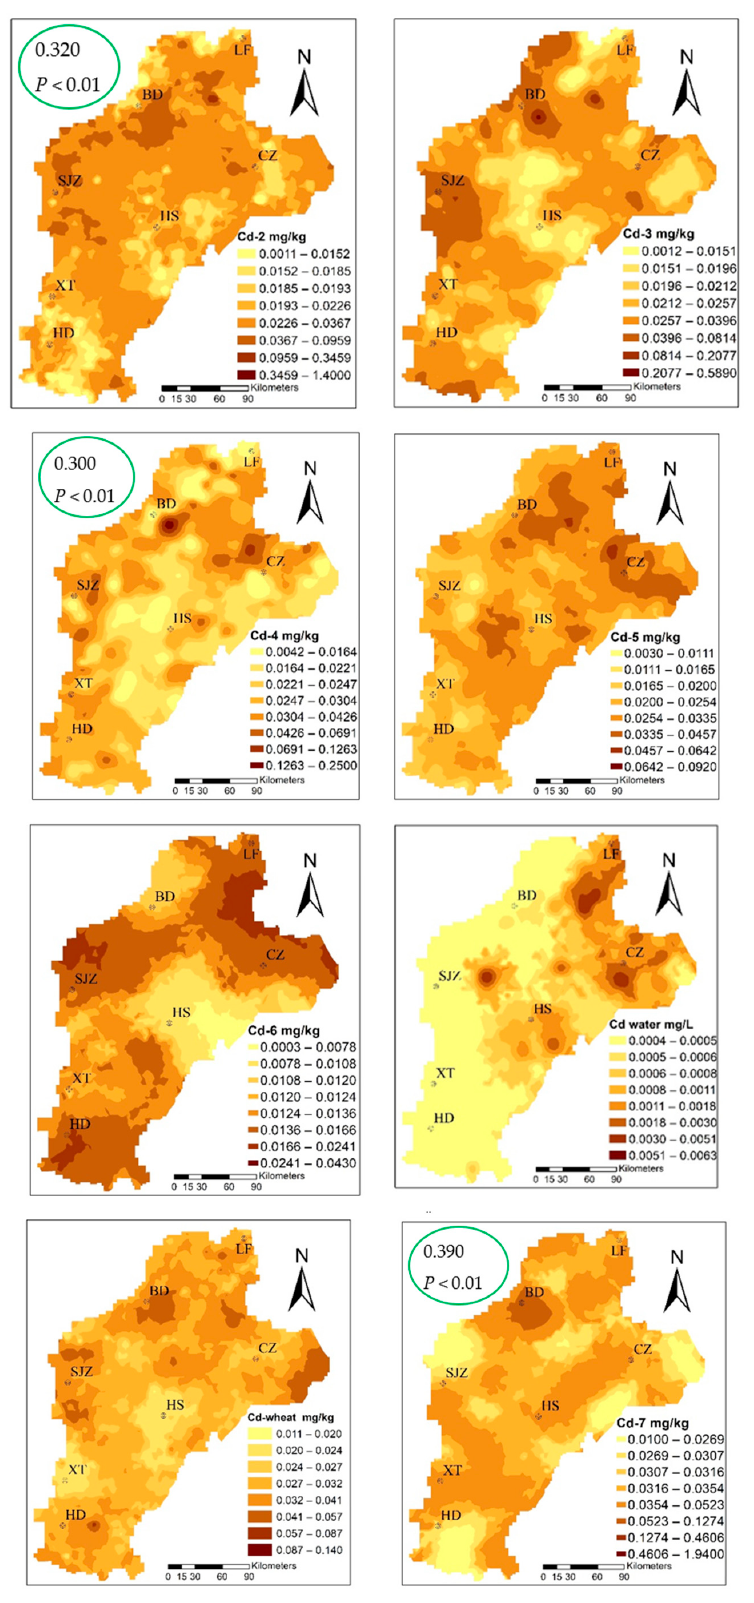
Figure 5. Spatial distribution of cadmium speciation and in multiple media (the green circles highlight the correlation coefficient between Cd-2, Cd-4, Cd-7, and Cdwheat).